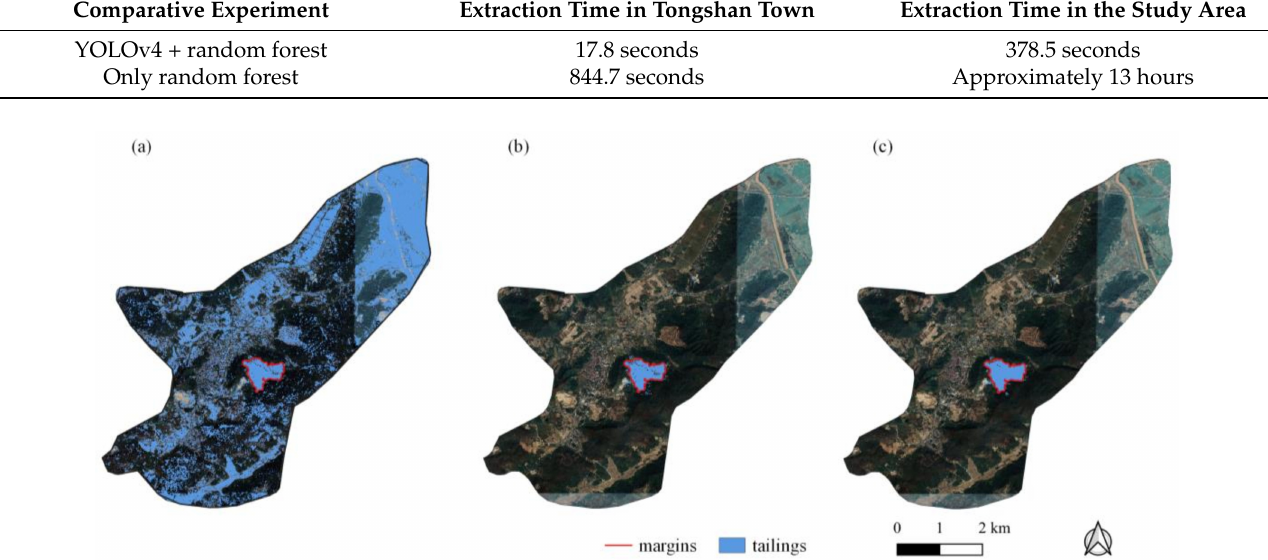
Figure 9. The extraction results of tailings ponds in Tongshan town based on different methods. ( a ) was the extraction result by plain random forest, ( b ) was the extraction result by YOLOv4+random forest model and ( c ) was the result of the whole framework (YOLOv4 + ranodm forest+ morphological